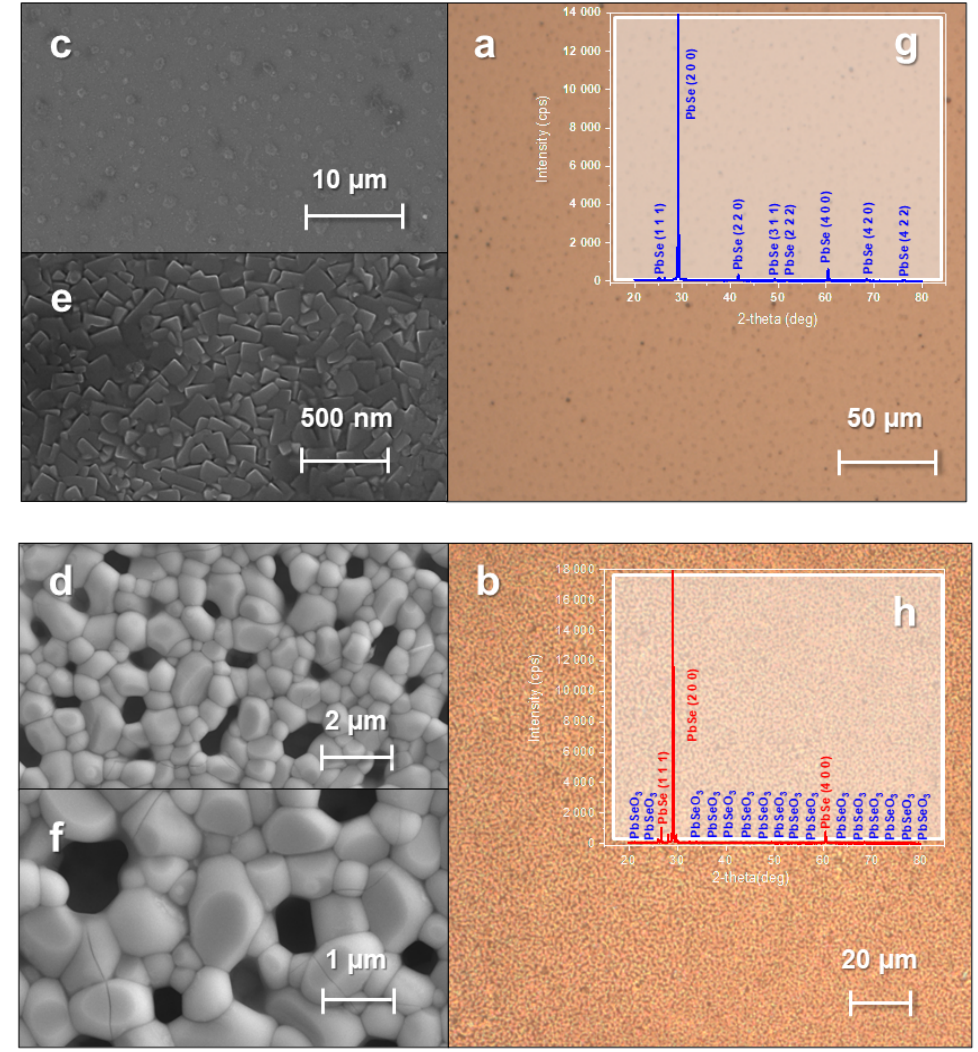
Figure 3. Images of a PbSe film obtained using optical microscopy in bright field reflected light: ( a ) initial film; ( b ) film after heat treatment. Pictures of the PbSe film obtained with the SEM secondary electron detector: ( c , e ) initial film; ( d , f ) film after heat treatment. A picture of the PbSe film obtained using an X-ray diffractometer ( g ) initial film; ( h ) after heat treatment.